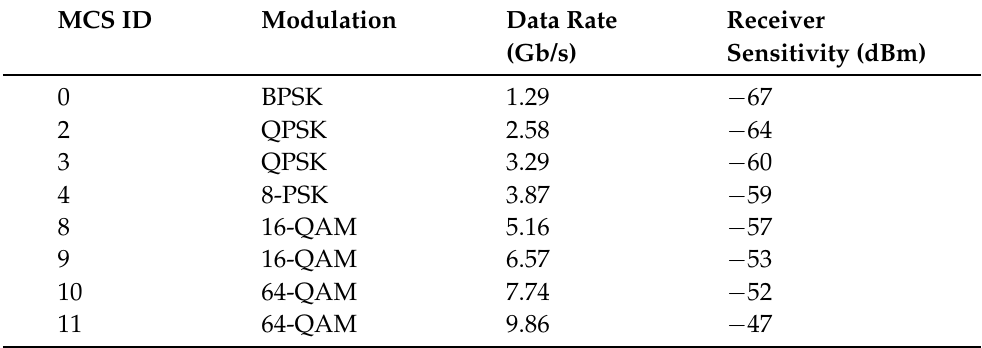
Table 2. Utilized modulation and coding